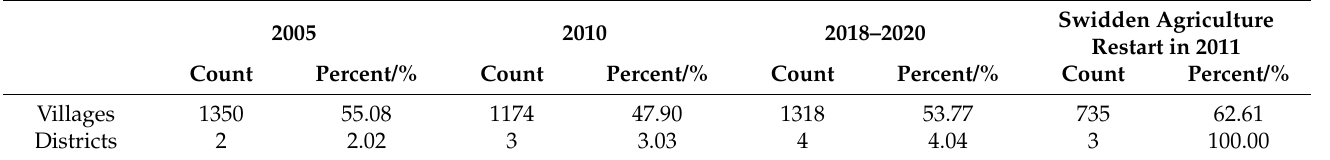
Table 3. Statistics of villages and districts which stop or restart swidden agriculture related to the arrangement of the national policy of eradicating shifting cultivation in Laos during 2001–2020.